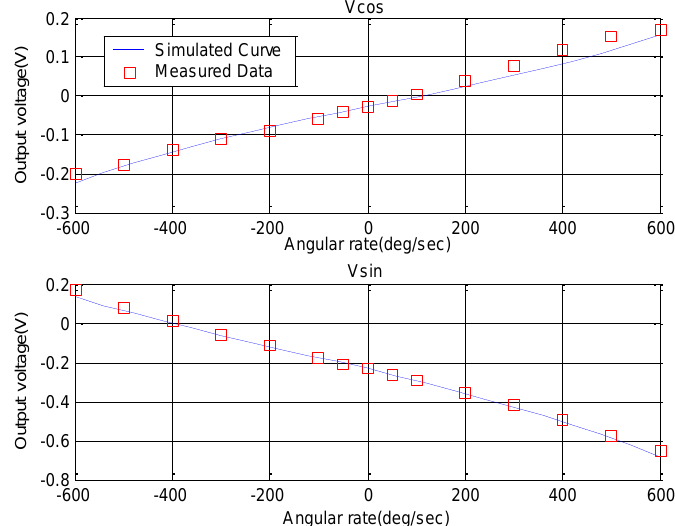
Figure 7. Tow orthogonal components of the output vector versus the angular rate in a dual-phase measurement for device